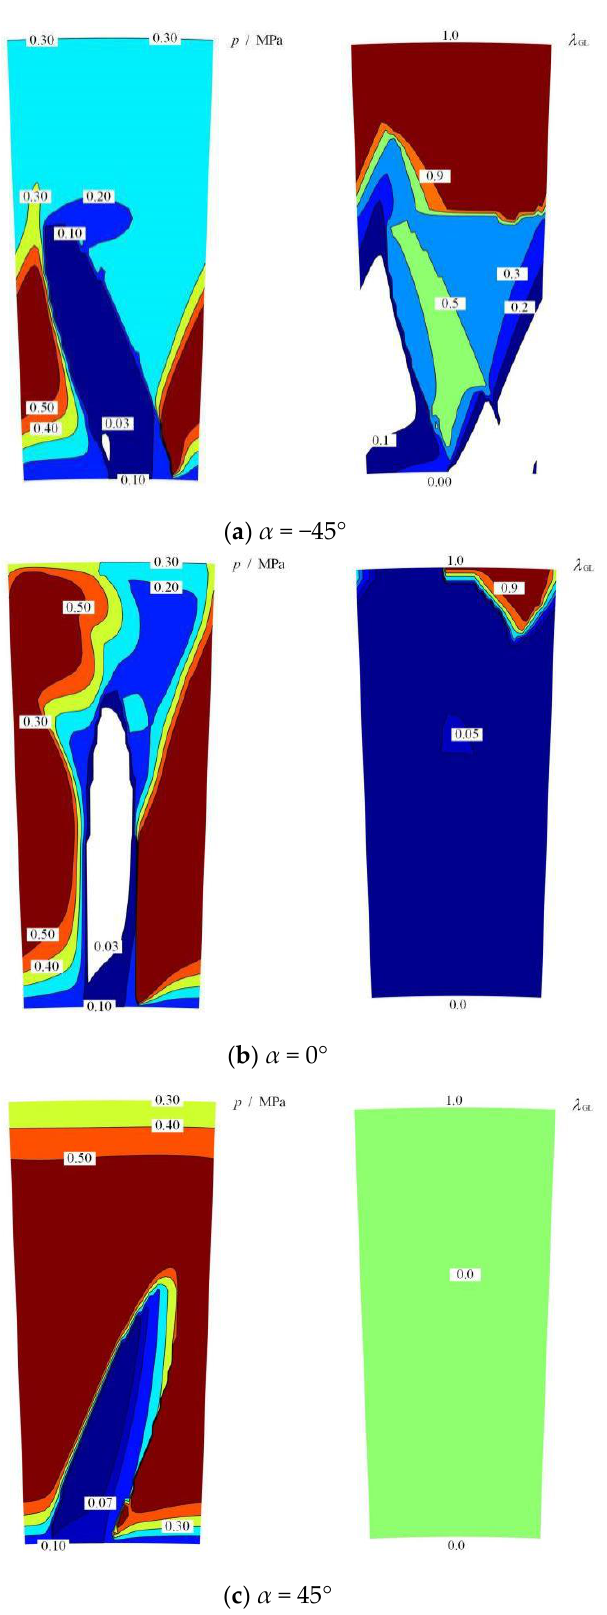
Figure 4. Distributions of film pressure and gas – liquid medium with various inclined angles: ( a ) α = −45°, ( b ) α = 0° and ( c ) α = 45° ( ω = 2000 rpm, p o = 0.3 MPa, h 0 = 2 μm, γ = 3.5 and N = 36). ( a ) α = − 45 ◦ , ( b ) α = 0 ◦ and ( c ) α = 45 ◦ ( ω = 2000 rpm, p o = 0.3 MPa, h 0 = 2 µ m, γ = 3.5 and N =